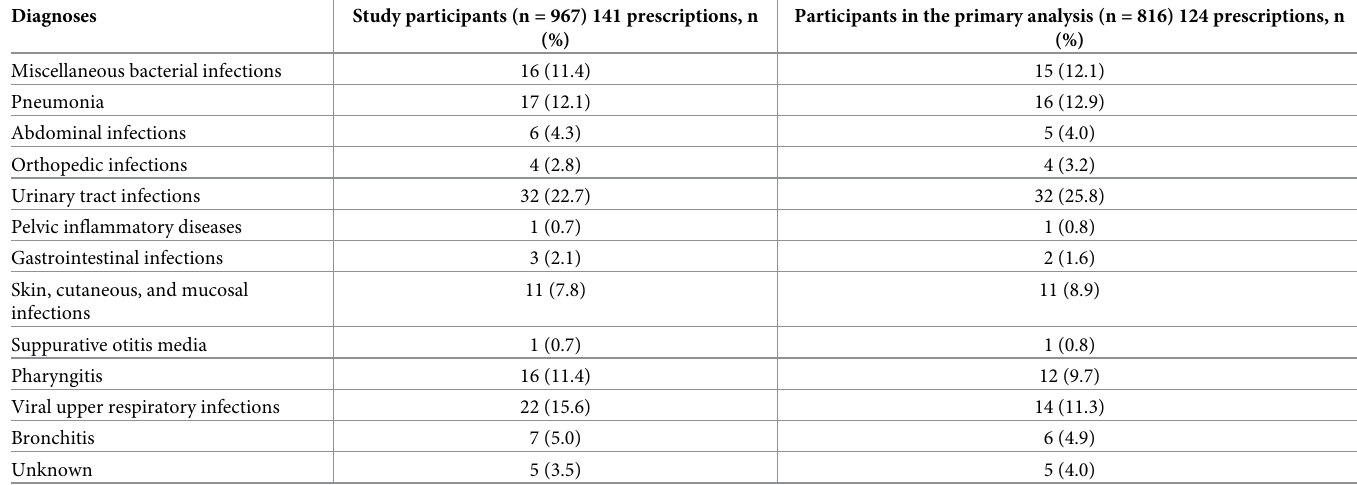
Table 3. Antibiotic prescriptions for infectious disease diagnoses.